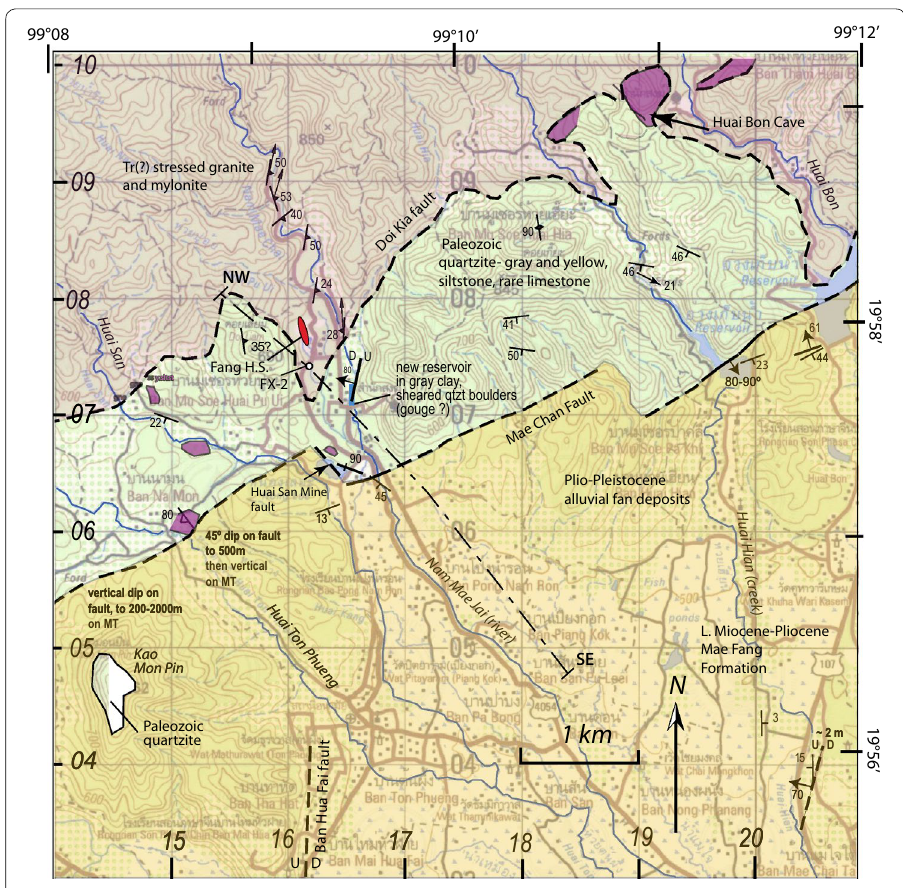
Fig. 9 Geologic map of the Fang geothermal area based on mapping by the authors (2014–15) and by Chi- ang Mai University (Ensol Co., Ltd. 2015). The irregular contact of Paleozoic sedimentary rock with crystalline rocks is interpreted as a low-angle normal fault, called the Doi Kia fault. FX-2 is the geothermal well south of the hot springs. Limestone outcrops in purple color. Coordinates are UTM,